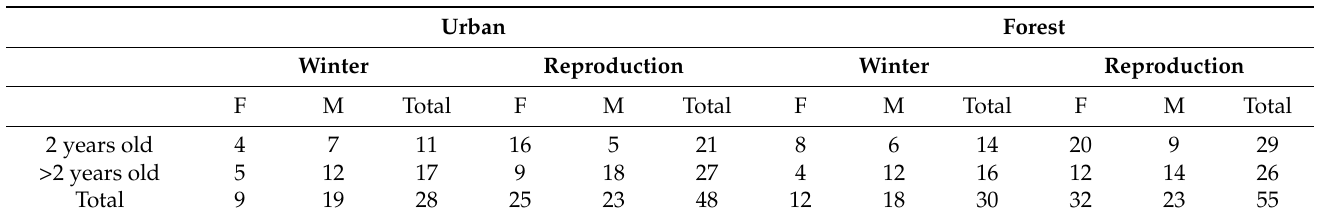
Table A2. Number of Birds in each Age Category at Different Seasons for Urban and Forest Site.